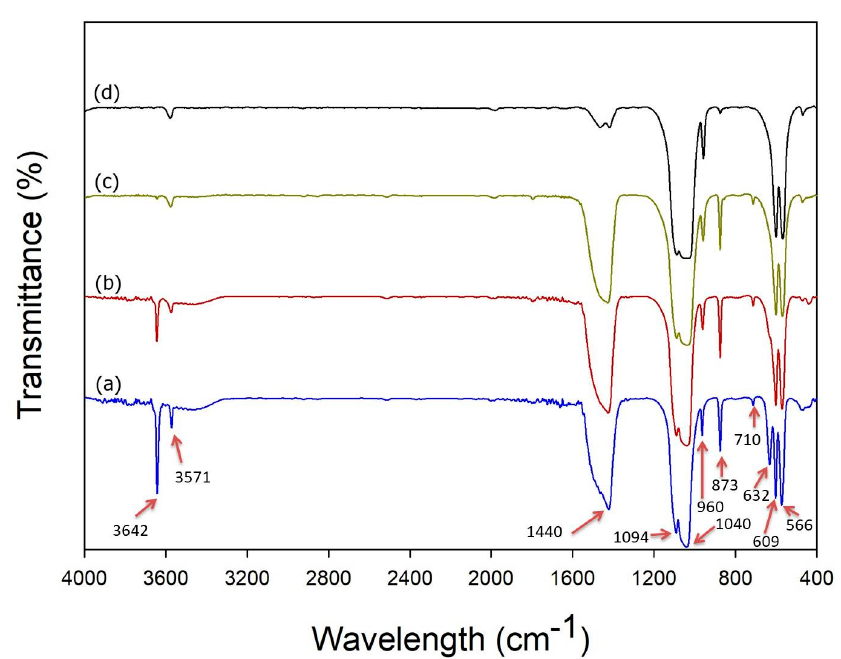
Figure 4. Fourier transform infrared spectroscopy (FTIR) spectra of ( a ) 0mSrHANFs, ( b ) 1mSrHANFs, ( c ) 2mSrHANFs, and ( d ) 3mSrHANFs.